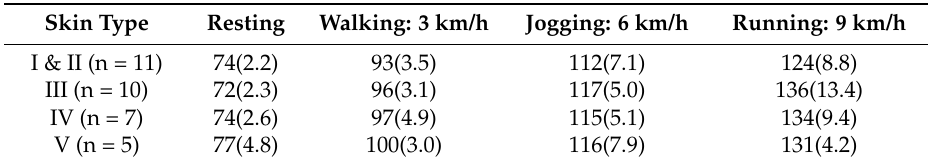
Table 4. Average value of HR and standard deviation with four skin types under exercises (n is number of subjects).